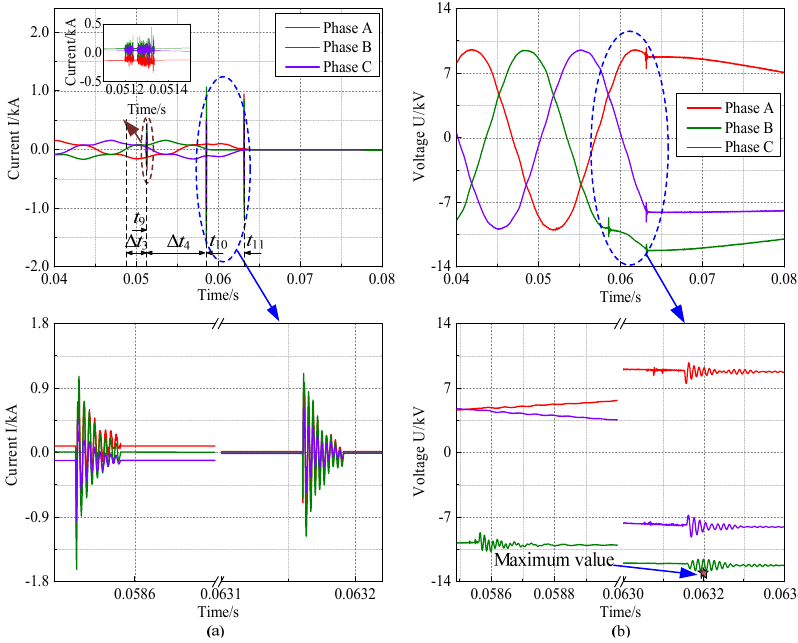
Figure 13. Waveforms of the opening current and capacitor voltage in Case 6. ( a ) Current waveform; and ( b ) voltage waveform.